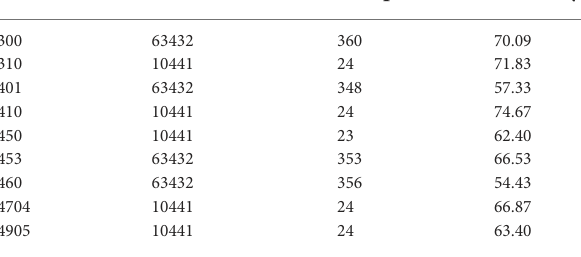
TABLE 5 Performance of communication (MB/epoch), computation (s/epoch) and accuracy (%). Question